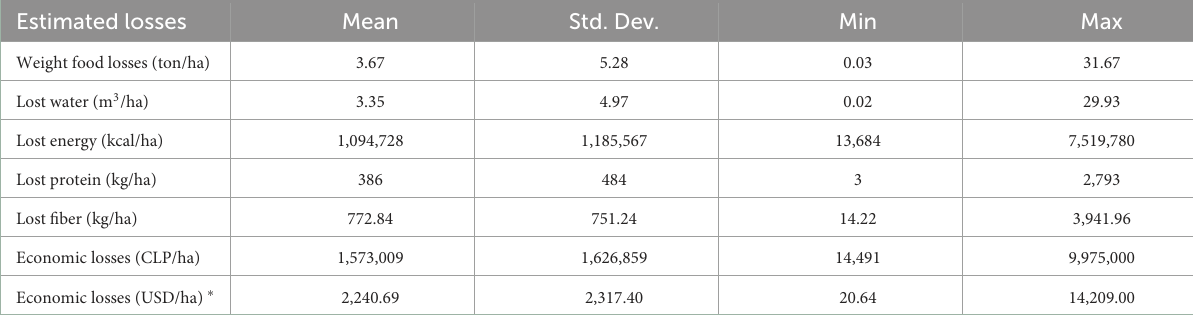
TABLE 2 Loss estimation calculated from farmers’ perception. Estimated